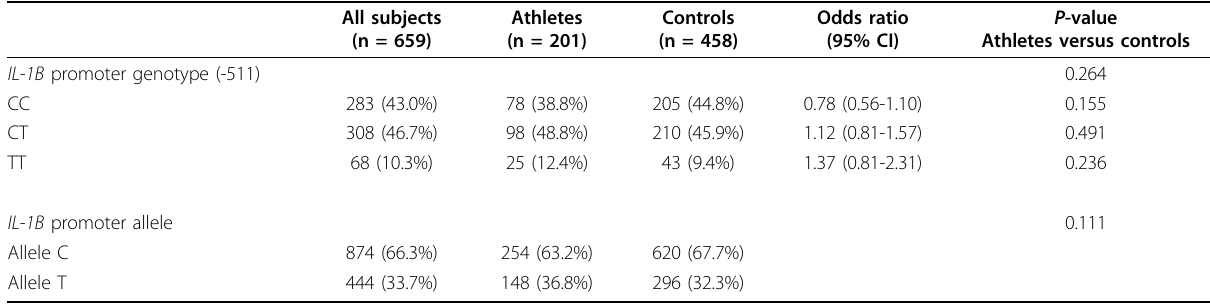
Table 2 Genotype frequencies of IL-1B promoter at position -511 in 659 white subjects, comparison of 201 athletes and 458 non-athlete controls